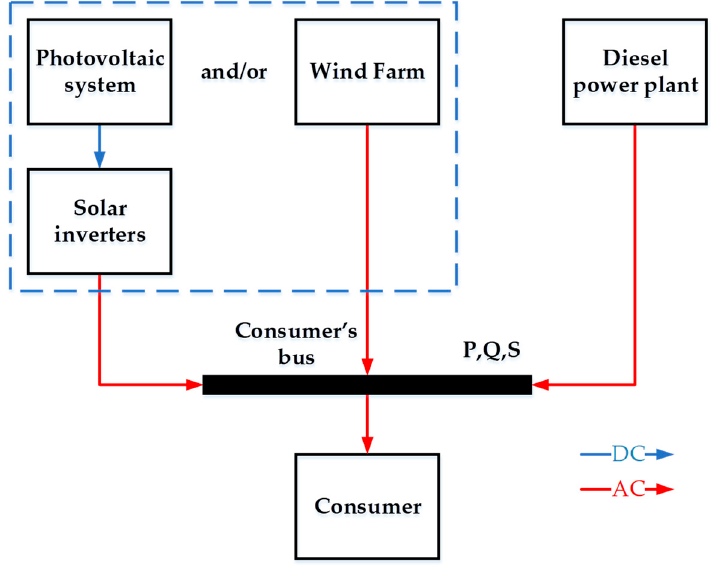
Figure 2. Parallel operation of photovoltaic system/wind farm and diesel power plant.